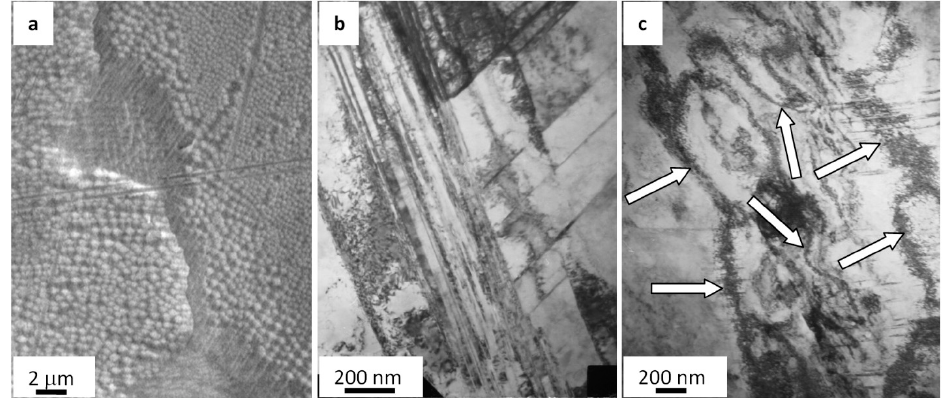
Figure 3. Electron microscopic image of steel surface treated with a pulsed electron beam: ( a ) SEM and ( b , c ) TEM.